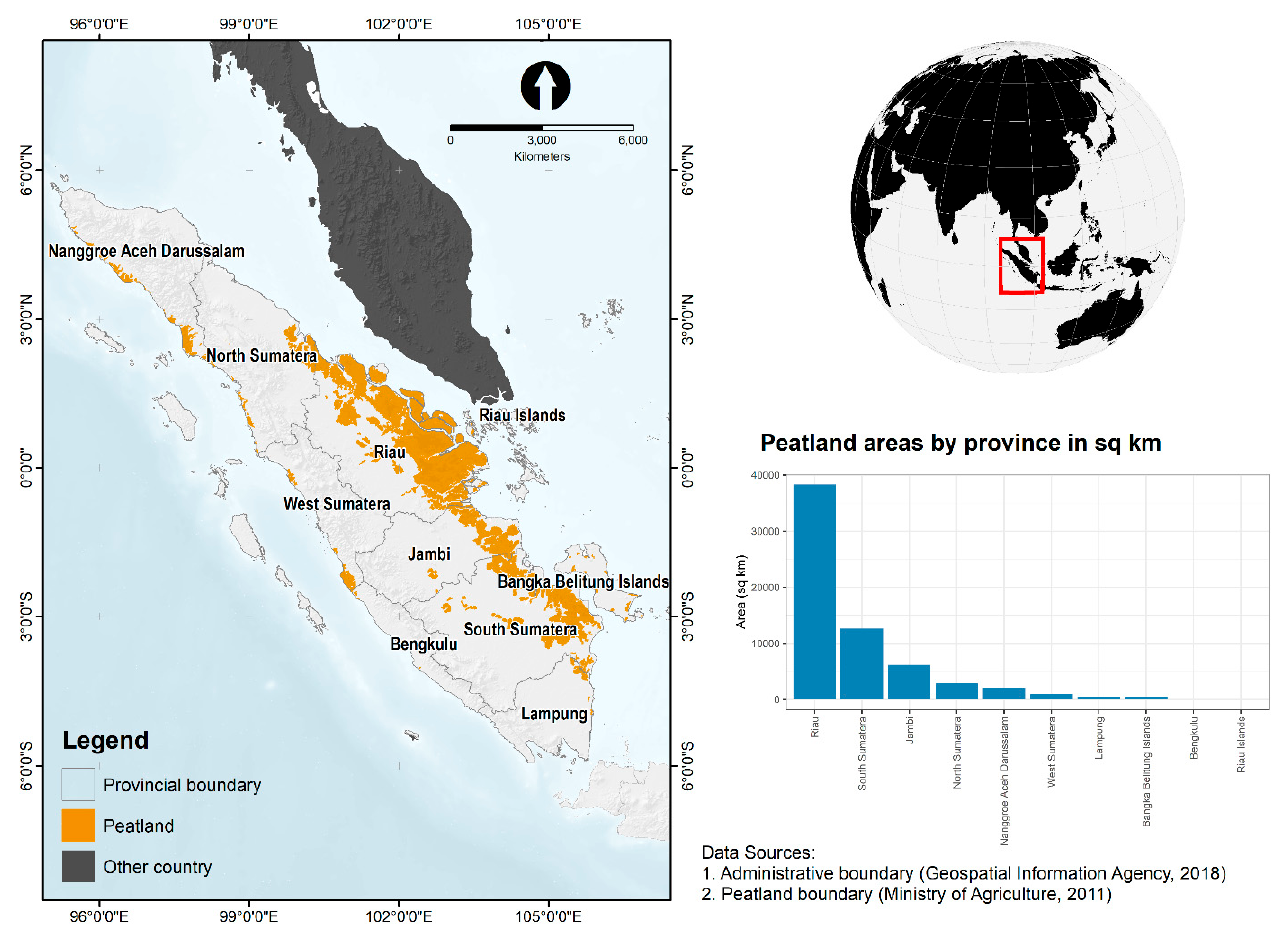
Figure 1. Map of the study area of the Sumatran peatland, Indonesia.